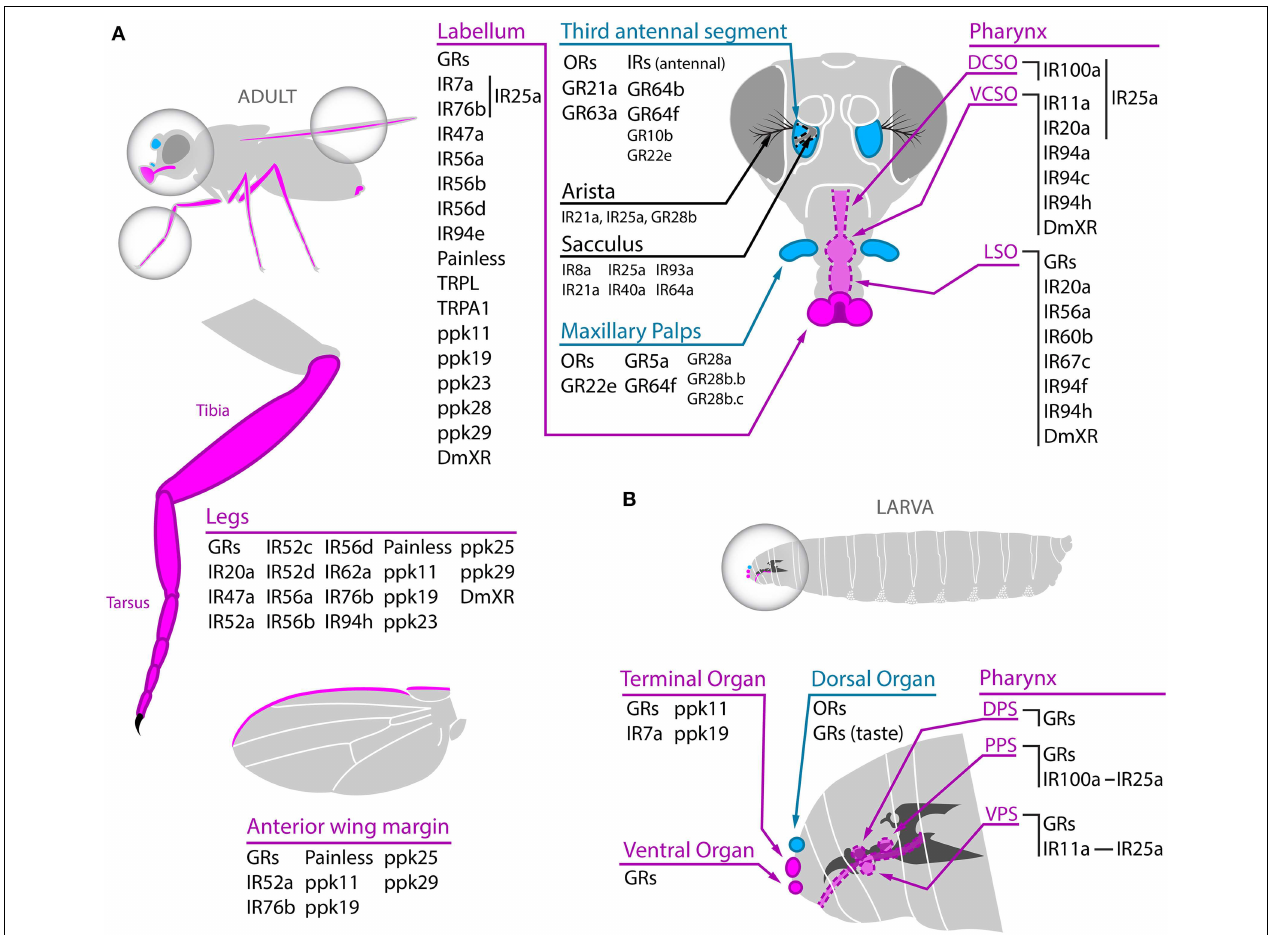
FIGURE 1 | Chemoreceptors expressed in adult (A) and larval (B) olfactory and gustatory organs. (A) Adult taste organs (magenta) are located on the proboscis’s labellum, the tarsus and tibia of the leg, the anterior wing margin, the female genitalia (not shown), and in internal taste structures in the pharynx (DCSO, VCSO, and LSO). Within those taste organs, GRs, several members of the IR family, some members of the TRP family (Painless, TRPL and TRPA1), ppk channels (ppk11, ppk19, ppk23, ppk25, ppk28, and ppk29), and the insect orphan receptor DmXR work as chemoreceptors (although some of them have not been confirmed as bona fide receptors yet). At least IR7a, IR76b in the labellum and IR11a, IR20a, and IR100a in internal taste organs are coexpressed with IR25a. The third antennal segment and the maxillary palps are the adult olfactory organs